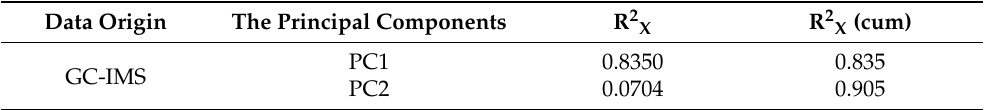
Table 3. Quality Parameters of OPLS-DA models.